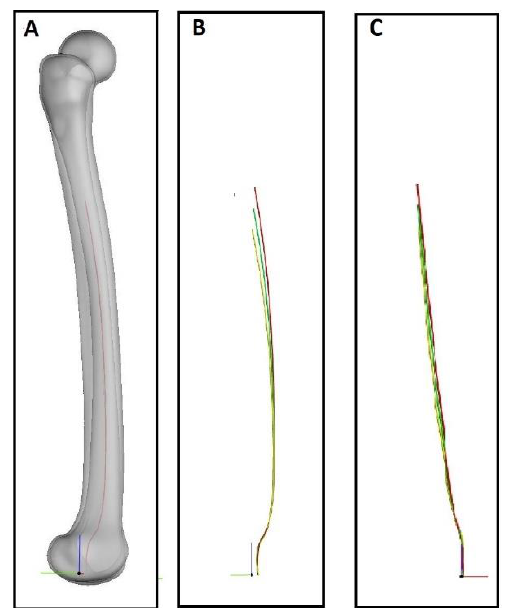
Figure 8. ( A ) Spline of the femoral canal; ( B ) splines of different sized SSMs (sagittal view); ( C ) splines of different sized SSMs (frontal view).